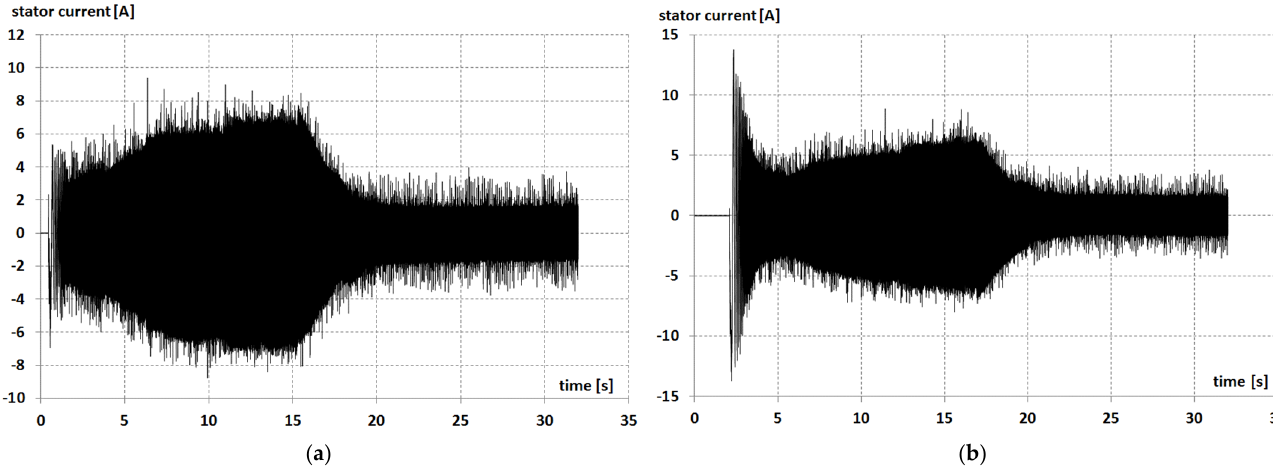
Figure 13. The measured waveforms of the instantaneous value of the current in the stator phase winding at the frequency start-up of the motor with a frequency rise time of 5 s and an initial voltage of 5% of the rated voltage ( a ) and 15% ( b ), for the motor with additional inertia mass ( J = 0.00454 kg m 2 ).